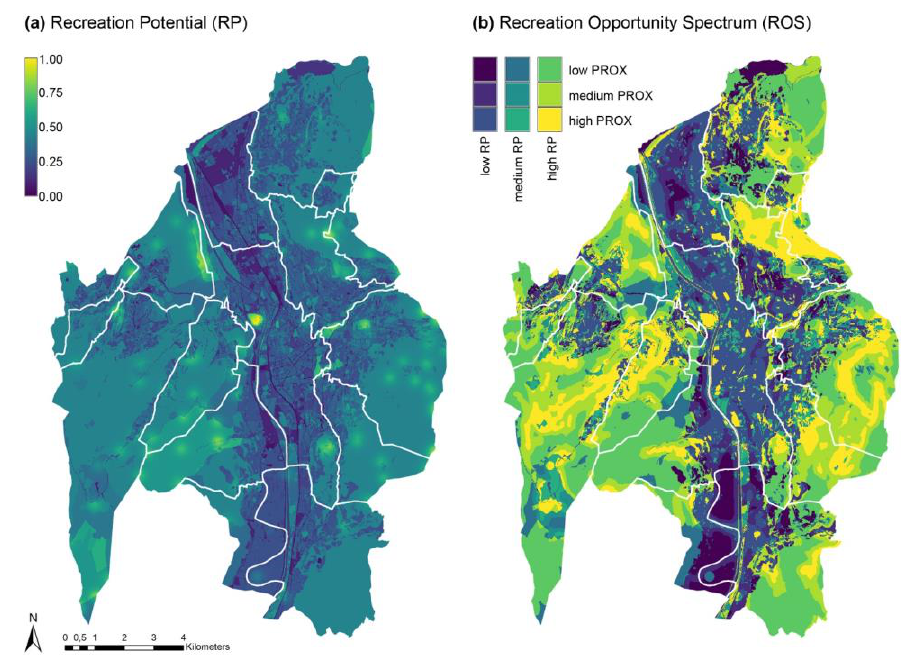
Figure 6. Maps of ( a ) Recreation Potential (RP) and ( b ) Recreation Opportunity Spectrum (ROS) in the city of Trento.